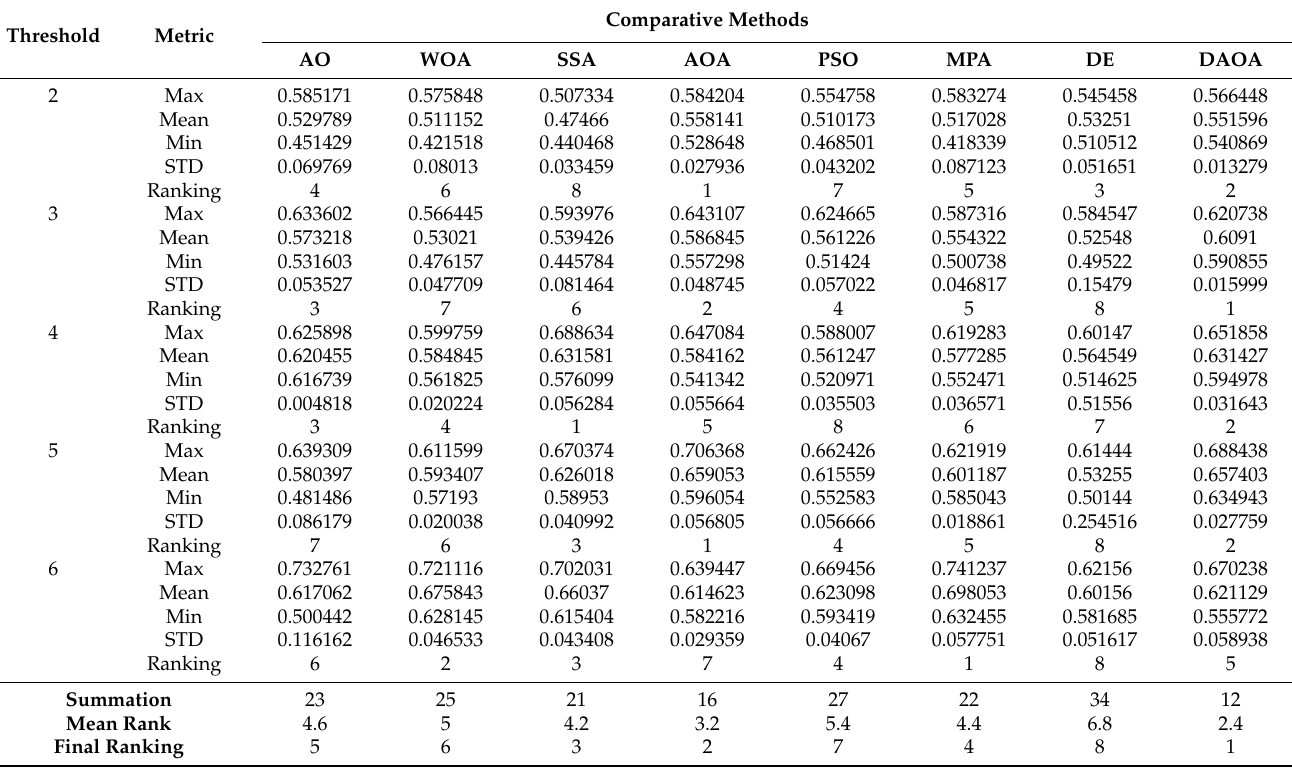
Table 13. The SSIM results of the test case